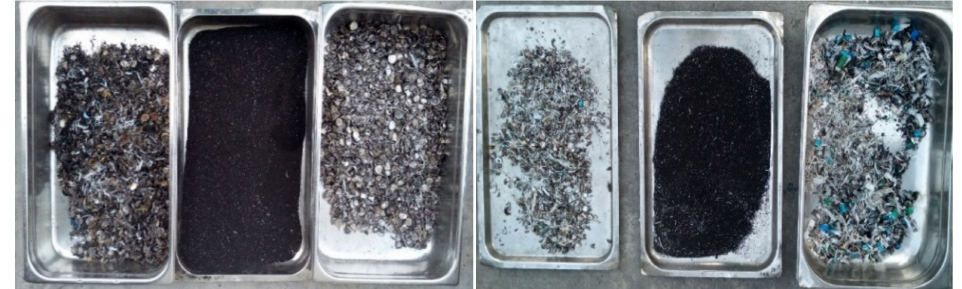
Figure 3. Solid fractions separated from the cryo-mechanical–sieving–separation sequence; from the left to the right: non-magnetic coarse fraction from coin cells, fine fraction from coin cells, magnetic coarse fraction from coin cells; non-magnetic coarse fraction from cylindrical cells, fine fraction from cylindrical cells, magnetic coarse fraction from cylindrical